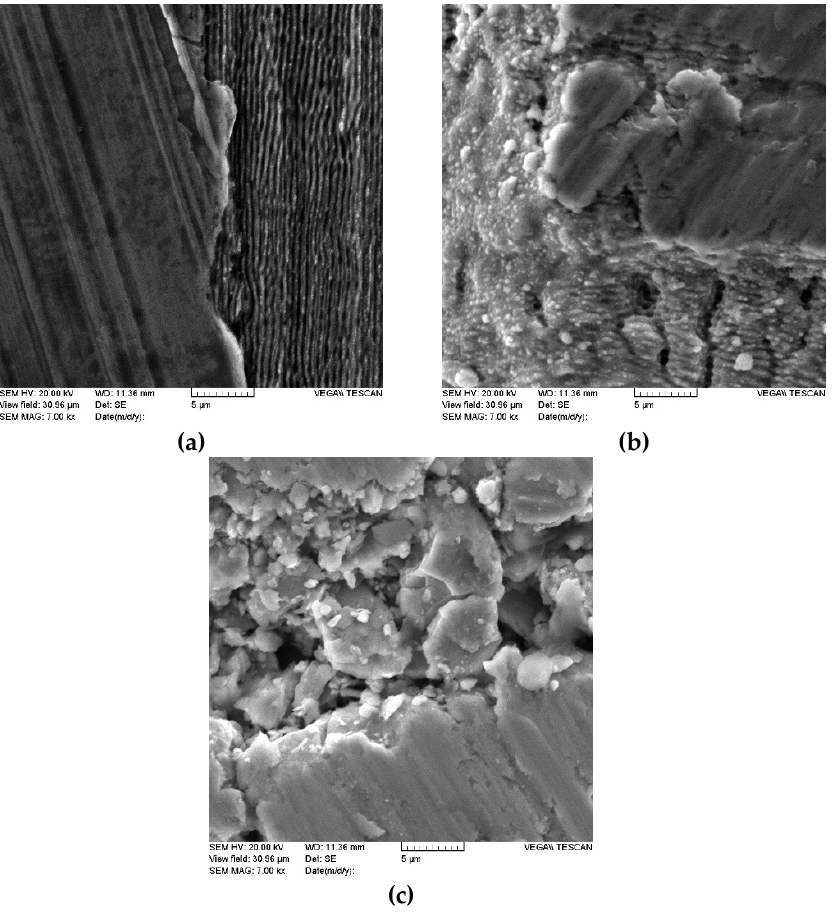
Figure 10. SEM images of the wear areas of samples surfaces: ( a ) 162-I, ( b ) 163-I, ( c ) and 164-I in the study of the friction coefficient.